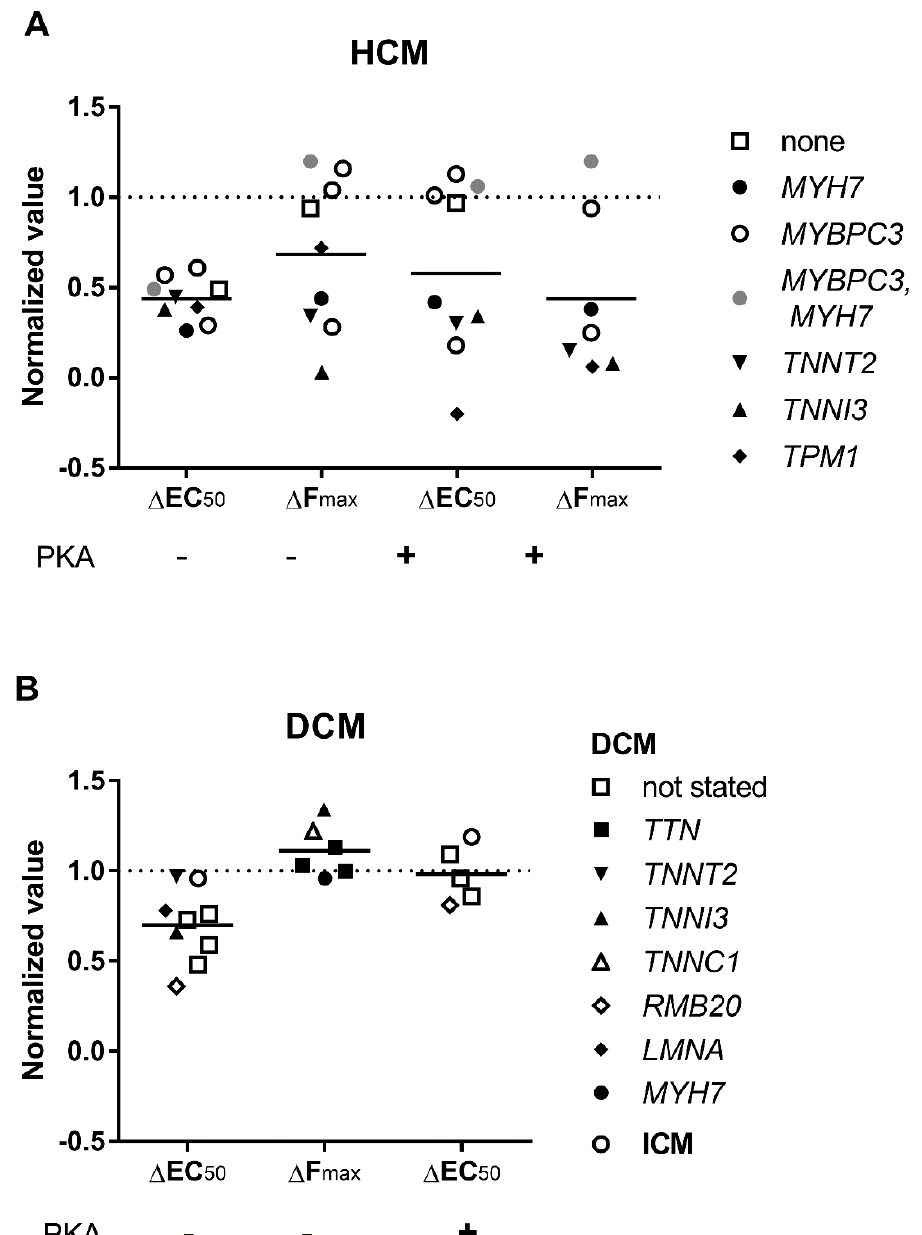
Figure 5. Length dependent activation in cardiac muscle. An increase in sarcomere length decreases EC 50 and increases F max . Each data point represents a different experimental group where the symbols indicate genes where mutations were found. The values for HCM ( A ) and DCM ( B ) are normalized to control donor hearts (dashed line). The data is from Tables 1 and 2.